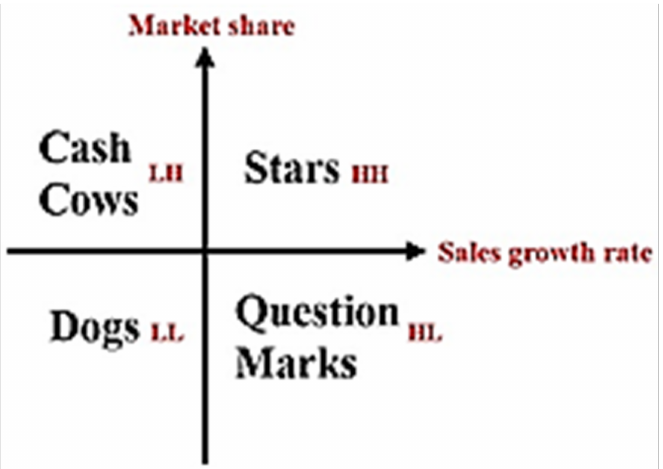
Figure 1. Schematic diagram of Boston Matrix.